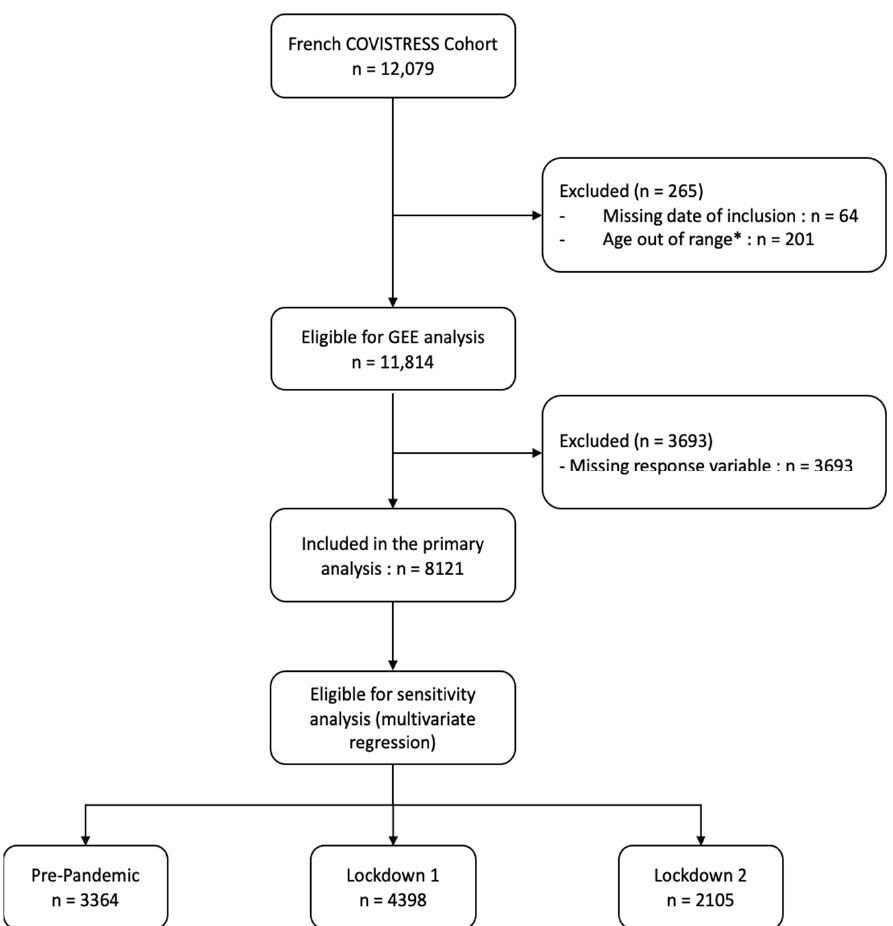
Figure 1. Flowchart of participants. Abbreviations: *: participants aged < 18 and > 75 were excluded from the analysis. Table 1. Participants’ characteristics, in the whole cohort and by periods of interest. *: The Pre ‐ pan ‐